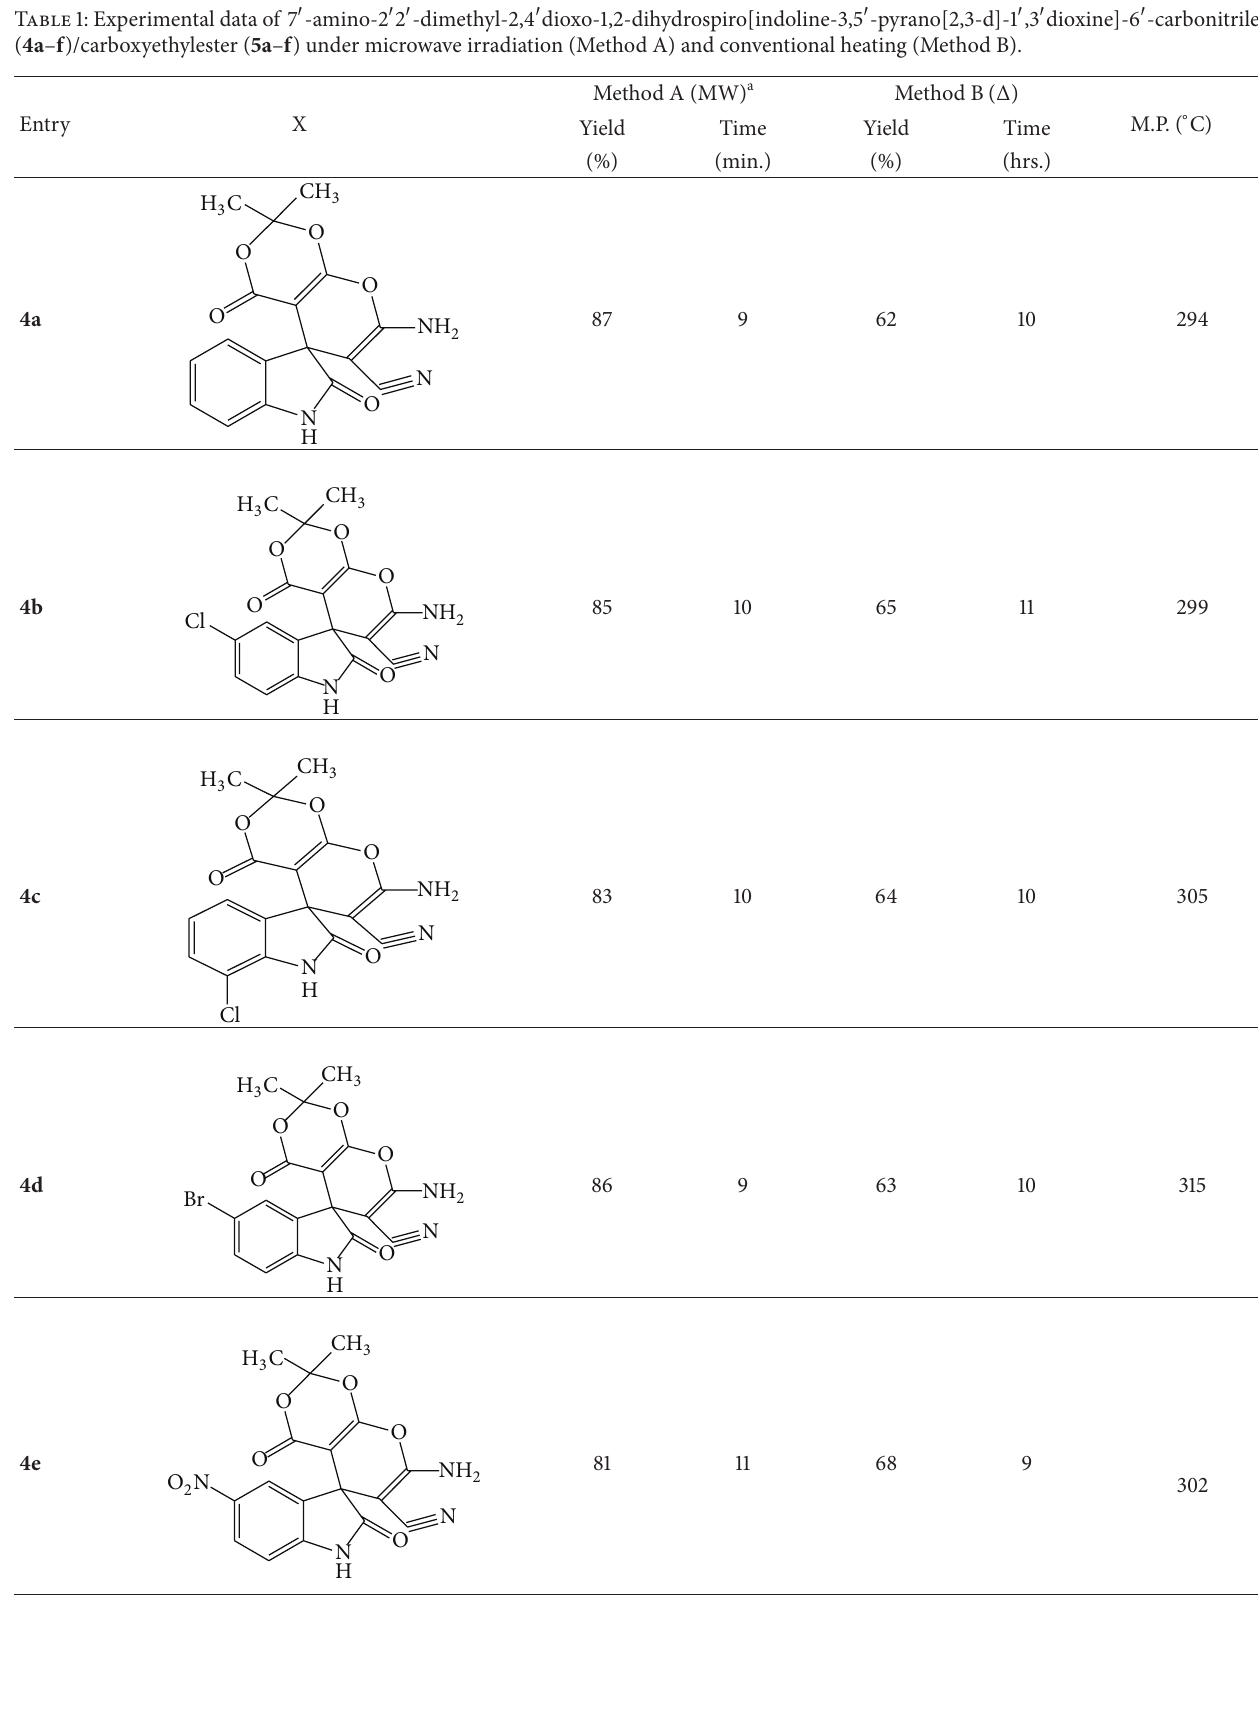
Table 1: Experimental data of 7 󸀠 -amino-2 󸀠 2 󸀠 -dimethyl-2,4 󸀠 dioxo-1,2-dihydrospiro [ indoline-3,5 󸀠 -pyrano [ 2,3-d ] -1 󸀠 ,3 󸀠 dioxine ] -6 󸀠